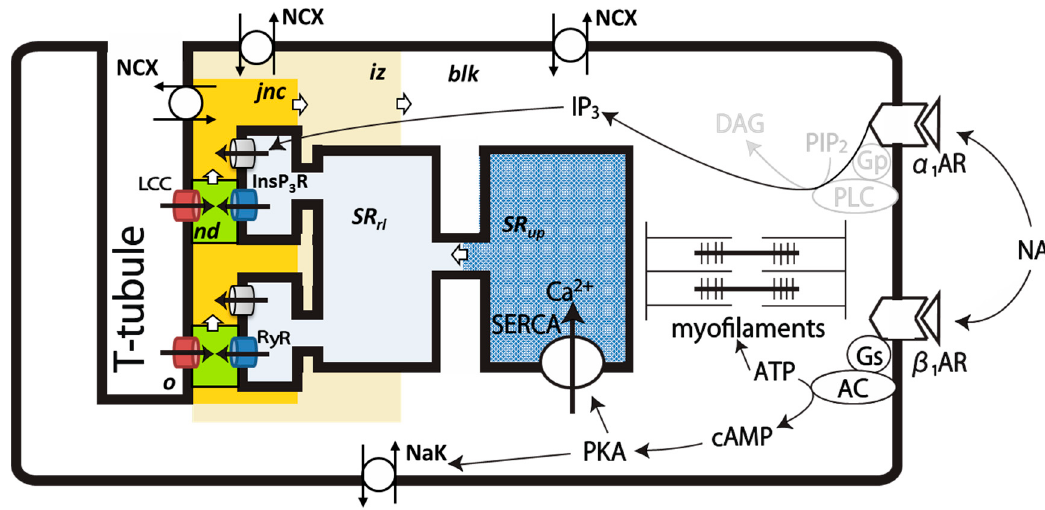
Figure 7. Signal transduction pathways for the α 1- and β 1-ARs, intracellular Ca 2+ compartments, and distribution of Ca 2+ -transporting channels and transporters. Components in gray are not included in the model. Open arrows between compartments indicate the usual diffusion paths of Ca 2+ . The activation of type II ryanodine receptors (RyRs) and inactivation of LCC are determined by [Ca 2+ ] nd . The Ca 2+ flux through InsP 3 R directs to jnc. If both LCC and RyRs are closed, [Ca 2+ ] nd equals [Ca 2+ ] jnc .